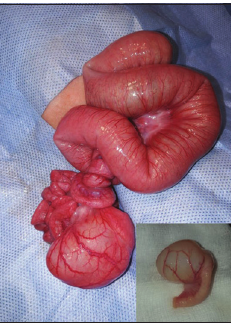
Figure 1: A cyst with twists of small bowel and its mesentery. Inset shows resected cyst attached to distal ileum